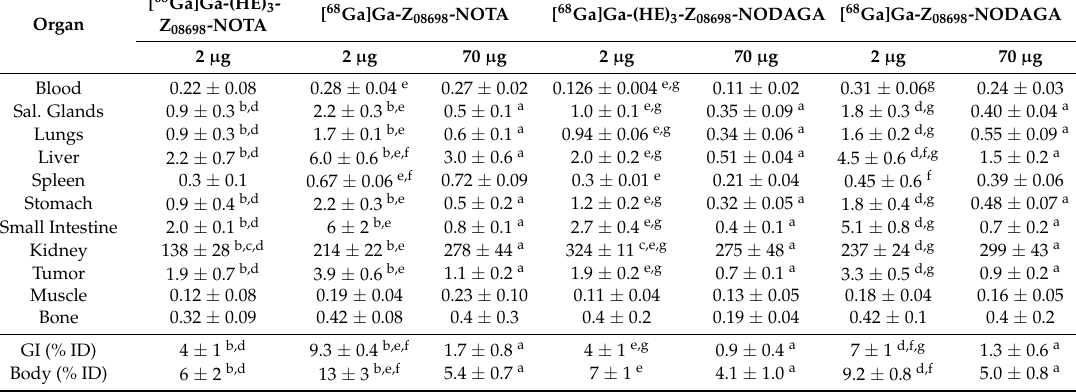
Table 2. In vivo biodistribution and specificity 3 h p.i. as %ID/g. Female Balb/c nu/nu mice with